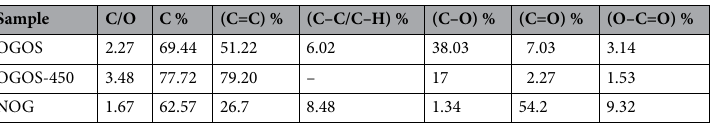
Table 1. Quantitative analysis of wide scan and deconvoluted high-resolution C1s XPS spectra of OGOS, OGOS-450 and NOG